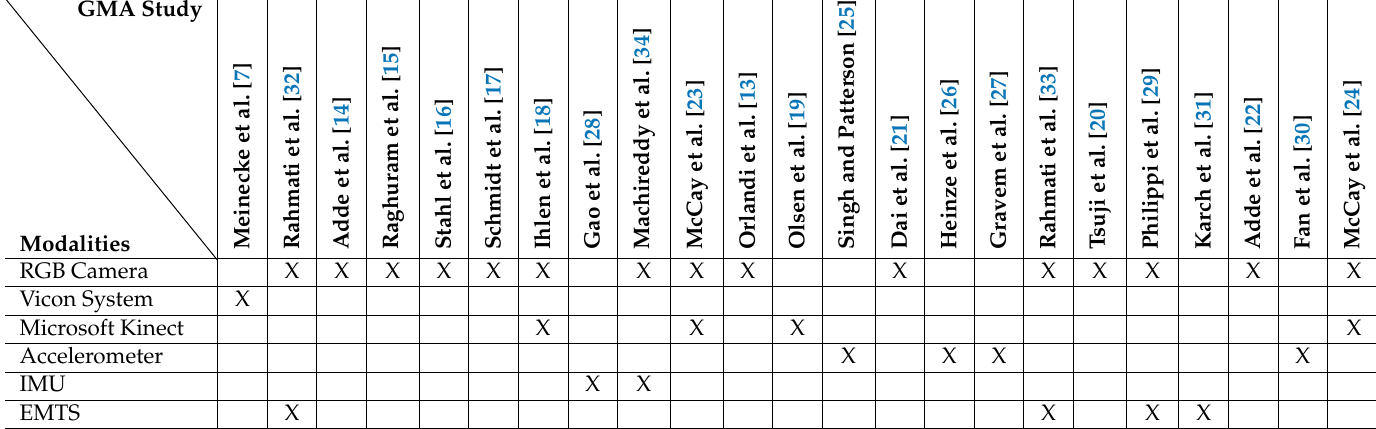
Table 2. The list of sensors used for the assessment of general movements (GMs) and fidgety movements